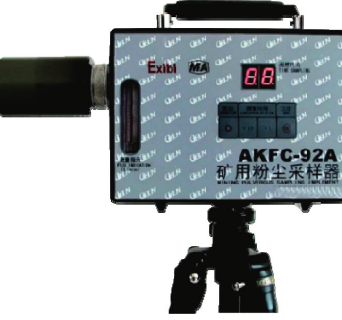
Figure 7: AKFC-92A mine dust sampler.